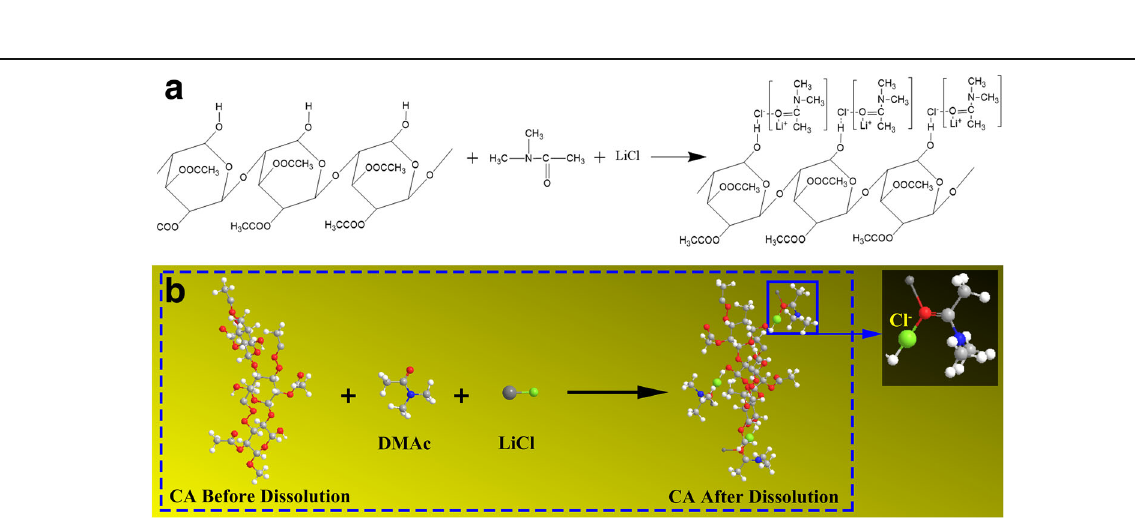
Fig. 5 Proposed mechanism for the dissolution of CA in the DMAc/LiCl solvent system: a molecular formula and b 3D molecular